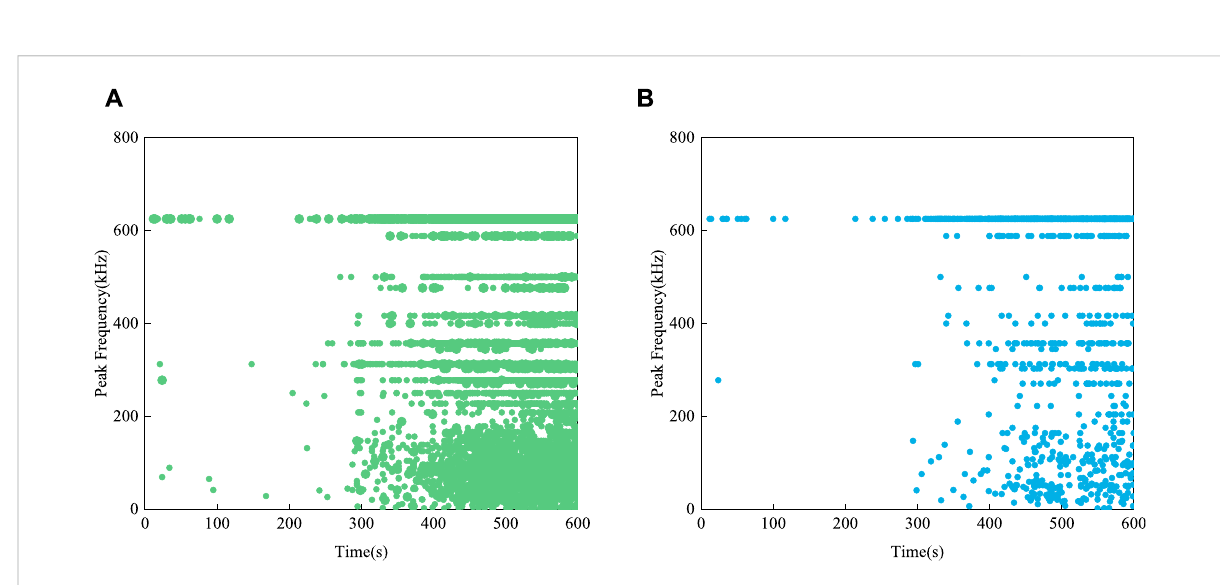
FIGURE 6 Temporal distribution of events with speci fi c peak frequencies showing: (A) all events and (B) only those with an initial frequency of 1,000 kHz.